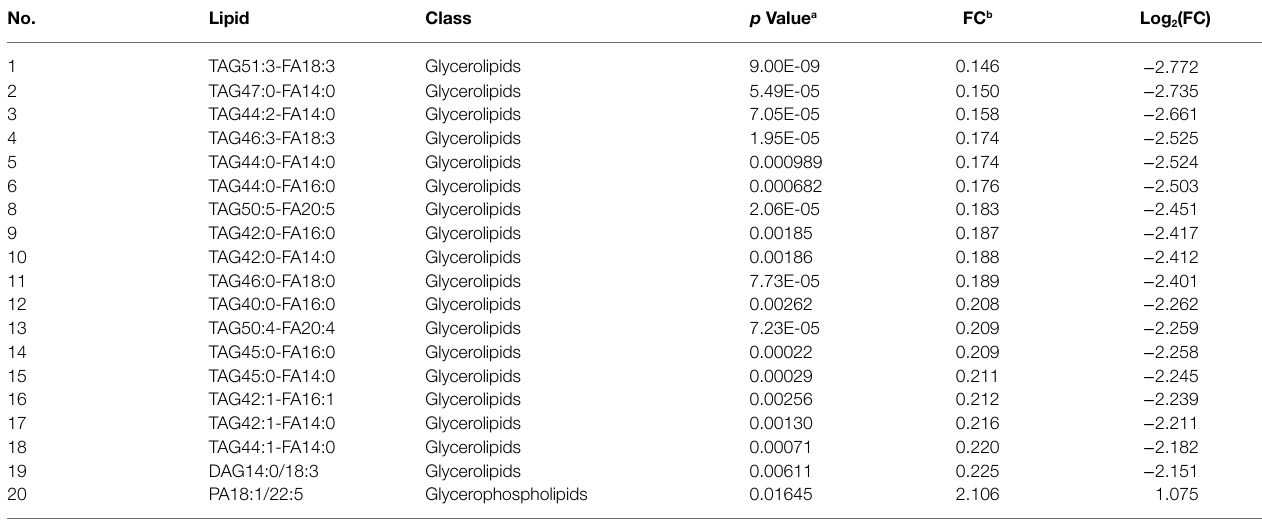
TABLE 6 | Top 20 lipids with different levels between NPC patients with a N0 tumor and NPC patients with N1, N2, or N3 tumor. No. Lipid Class p Value a FC b Log 2